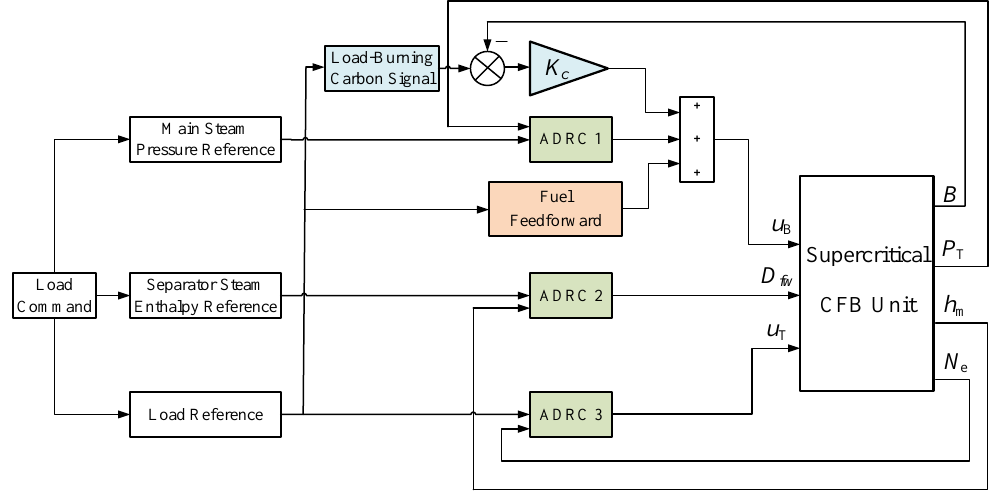
Figure 5. Structure of the burning carbon based decentralized active disturbance rejection control (ADRC) for a supercritical CFB